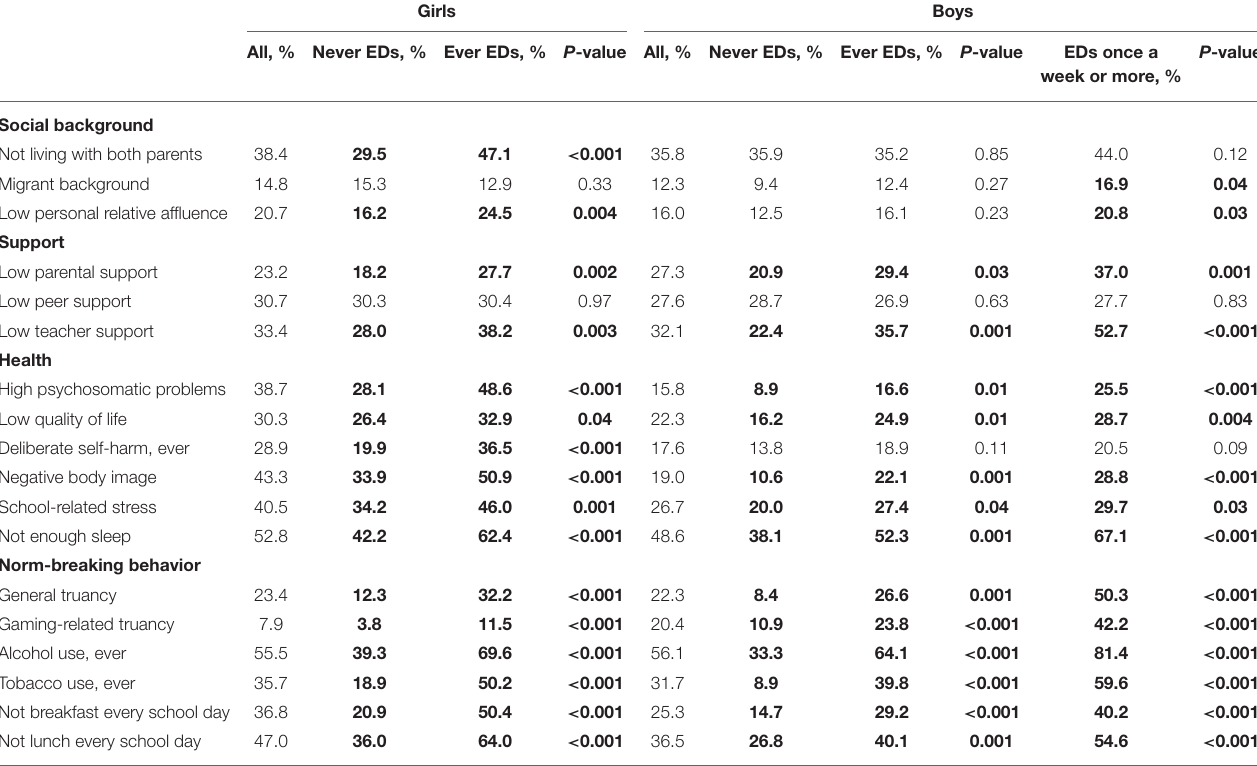
TABLE 3 | Characteristics (percentages) of girls and boys who reported to never or ever consume energy drinks (EDs), and boys who reported to consume EDs once a week or more, in 2010. Girls